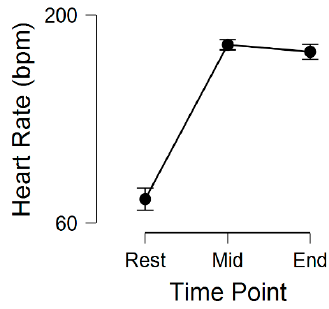
Figure 1. Physiological (heart rate) response to the acute bout (15 min) of treadmill exercise in the Reminder with Exercise group. Error bars represent 95% CI.